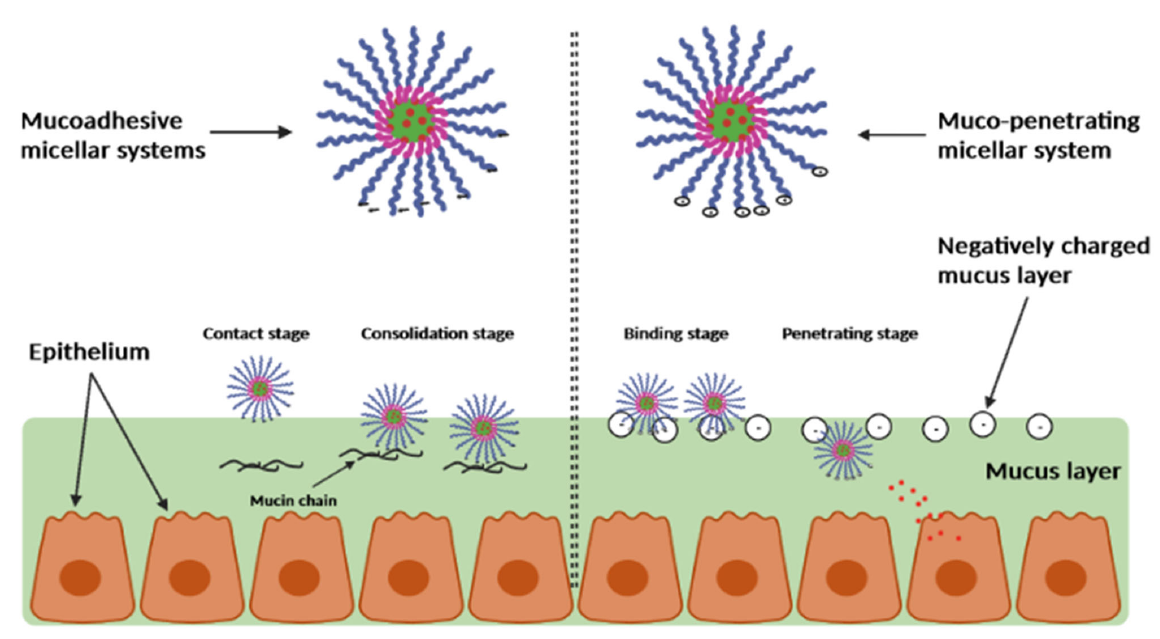
Figure 4. Schematic representation of the mucoadhesive and mucus ‐ penetrating strategy with pol ‐ ymeric micellar